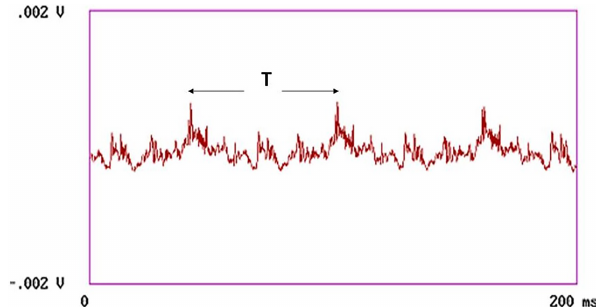
Figure 3. Typical roughness-dependent intensity function.